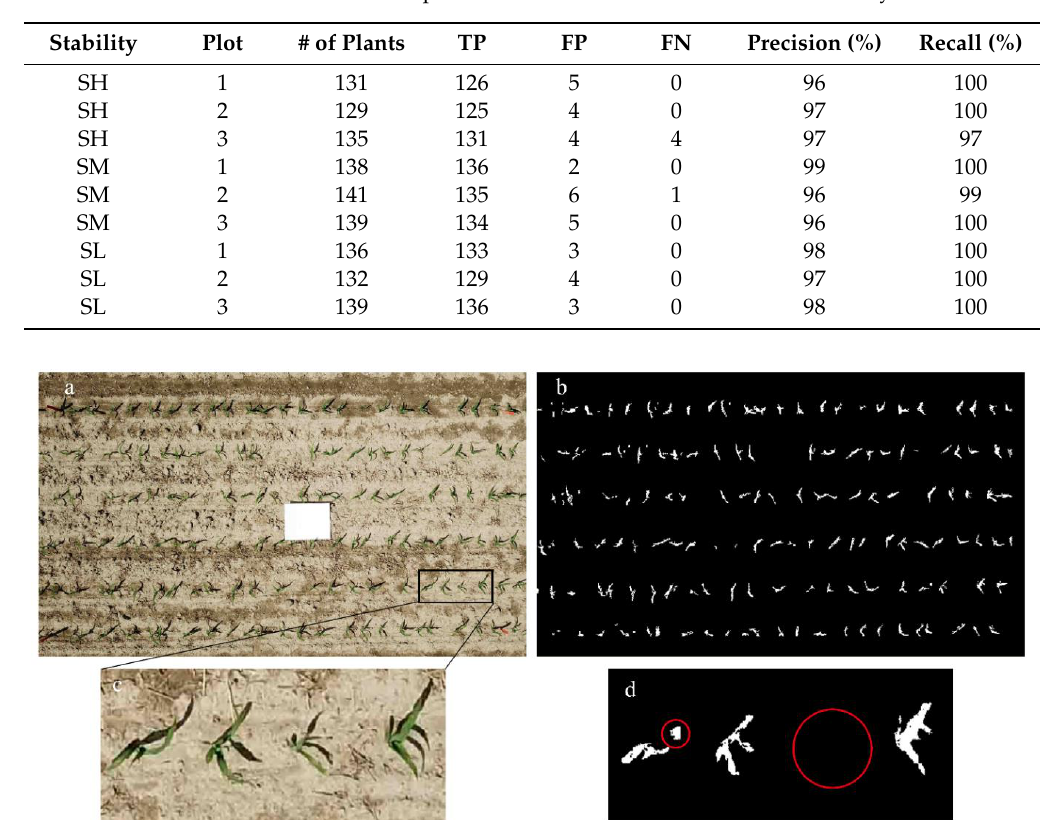
Figure 2. Example of maize plant identification and plant distance calculation ( a ) and ( b ), and associated classification errors ( c ) and ( d ) with red circles in ( d ). Table 1. Results of maize plant identification with its associated accuracy.